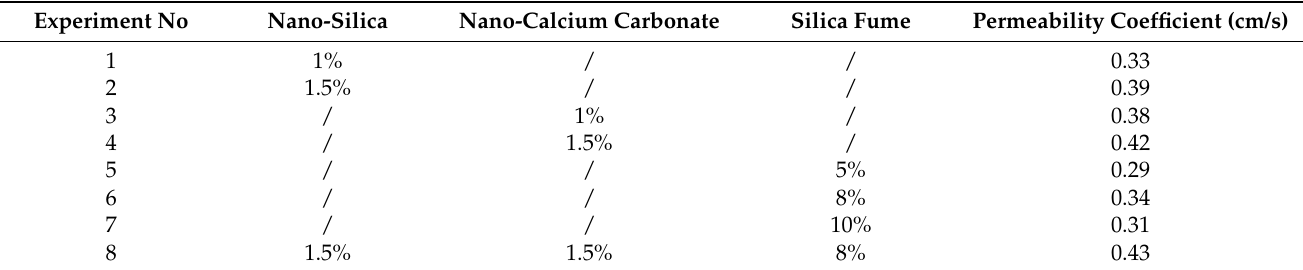
Figure 6. XRD analysis of pervious concrete. Table 1. Difference of permeability coefficient of pervious